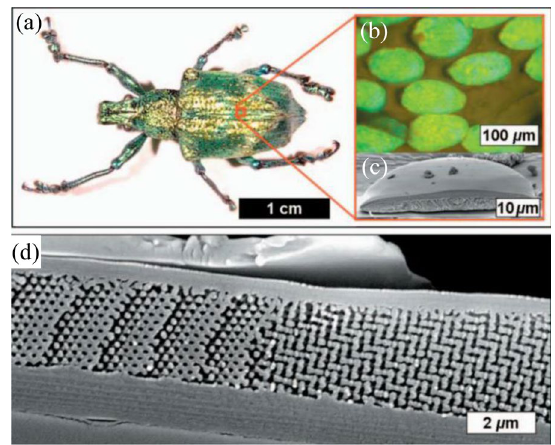
Figure 4 a Photograph of weevil L. augustus ; b Optical micrograph of a single scale on the exoskeleton of L. augustus under white light; c Single-scale cross-sectional SEM image; d Detailed cross-sectional SEM image [47]